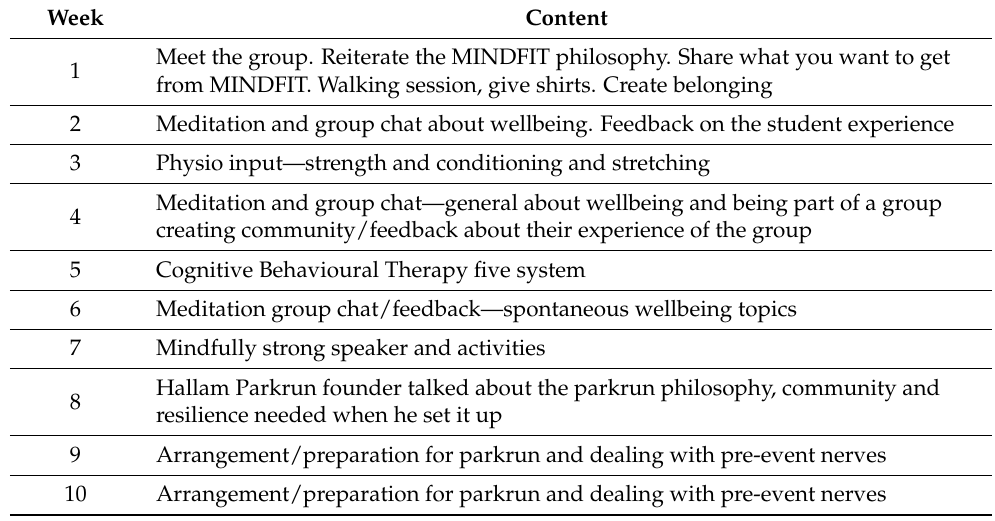
Table 1. Sessional